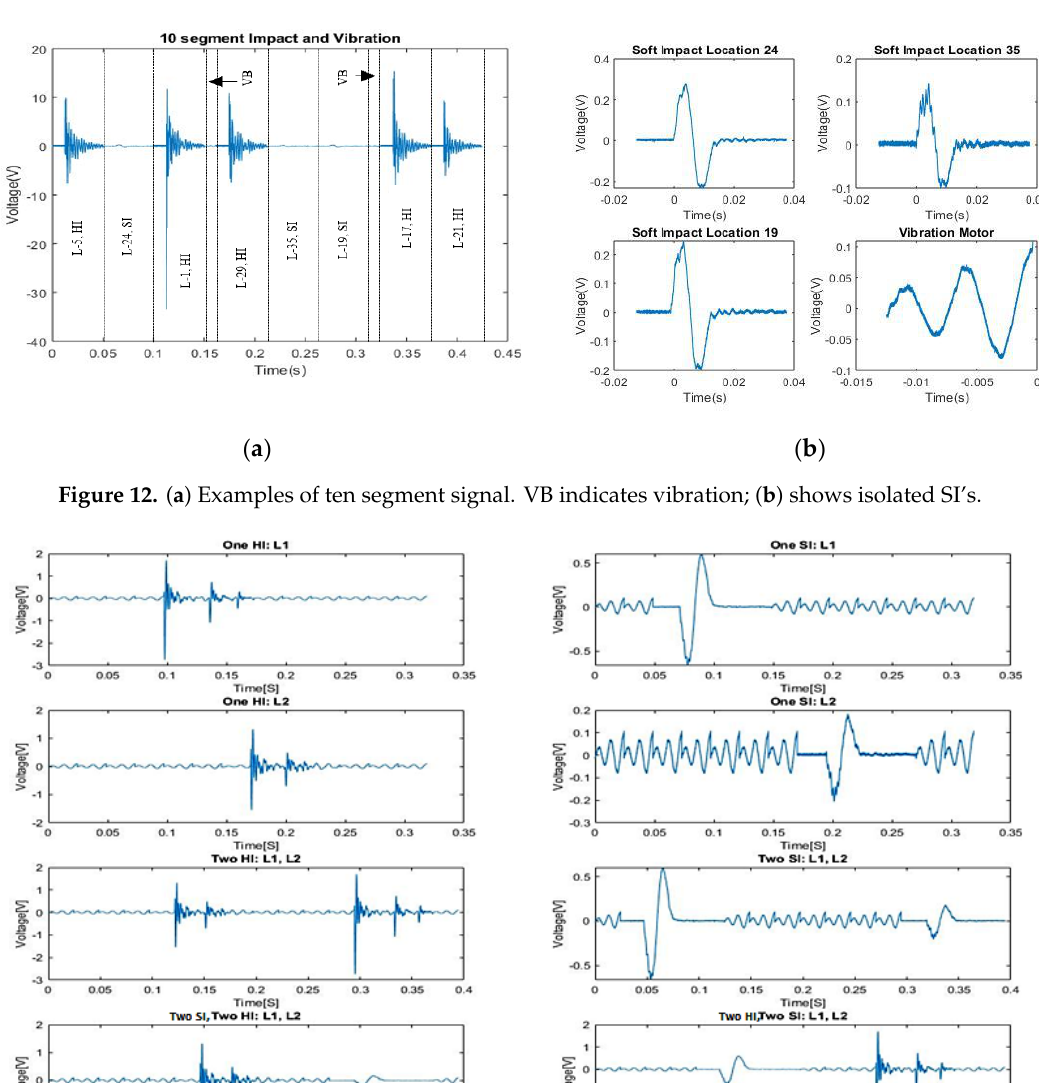
Figure 11. Final model structure.